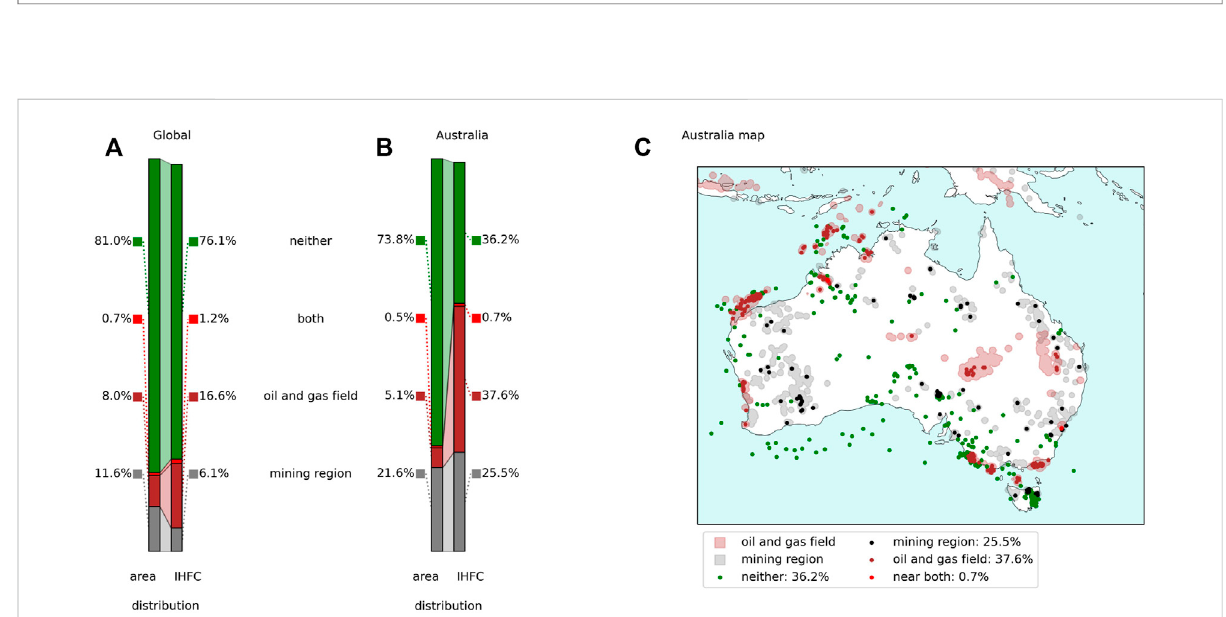
FIGURE 2 for each class to compensate for the difference between the distributions. The horizontal box plots show the heat fl ow distribution for measurementswithineachclass.Themeanheat fl owforeachclassisindicatedbyablacktriangularmarker( ▲ ).Themedianheat fl owforeachclass is indicated with the vertical line (|) within each box. Note that afew whiskers and bars are cropped (e.g. Juan de Fuca Plate in Figure 2E). Outliers are not indicated. The median and mean values for each class, and the corresponding weighted medians and means, are listed in Supplementary Table S1. Weighted average heat fl ow for each auxiliary variable shown as a dashed blue vertical line and given numerically in blue at the top. The value is calculated by assigning the mean heat fl ow for each class to the reference area. The median values for the weighted means are shown as a dashedorangeverticallineandanumericalvalueinorangeatthetop.Theverticallinesindicatethemean(green;205.3mWm − 3 )andmedian(purple; 64 mWm − 3 ) values of all IHFC database records (Fuchs et al., 2021b). Abbreviation used in the labels; bsn. = basin, cmplx = complex, interm. = intermediate, belts & mod. crt. = Precambrian belts and modi fi ed cratons, sed. = sediments or sedimentary rocks. All heat fl ow values are given in mW m − 2 ; units are omitted to minimise clutter.